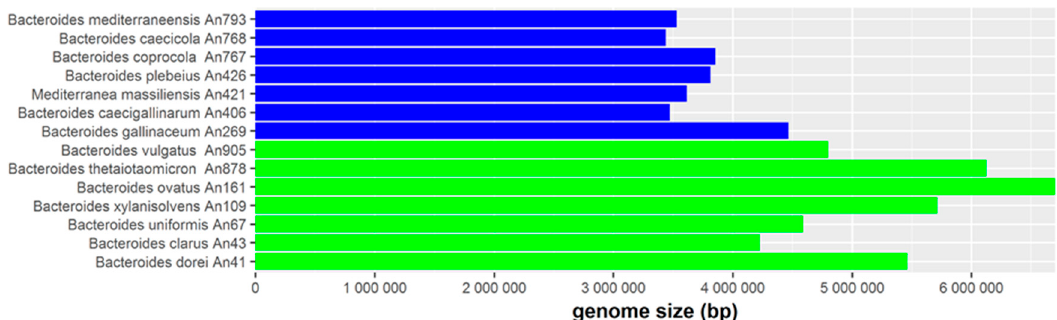
Figure 3. Genome size of chicken (blue columns) and human (green columns) adapted Bacteroides species. Human-adapted Bacteroides species exhibited a significantly higher genome size than chicken-adapted species (Mann–Whitney test, p < 0.05).